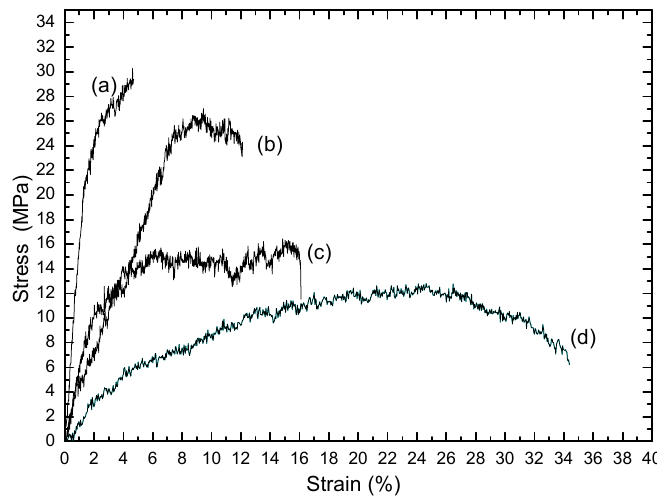
Figure 5. Stress-strain curves of nanofibers: ( a ) pure PHB with a speed of 610 rpm; ( b ) blend 2 with a speed of 610 rpm; ( c ) blend 2 (random); and ( d ) blend 1 (random).